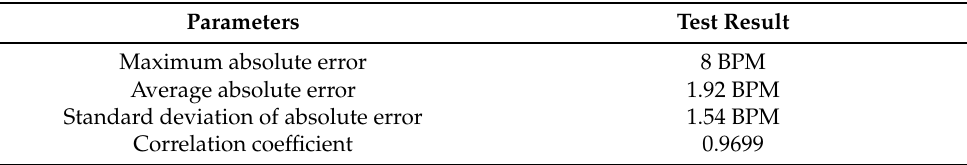
Table 4. ECG signal simulator test results.